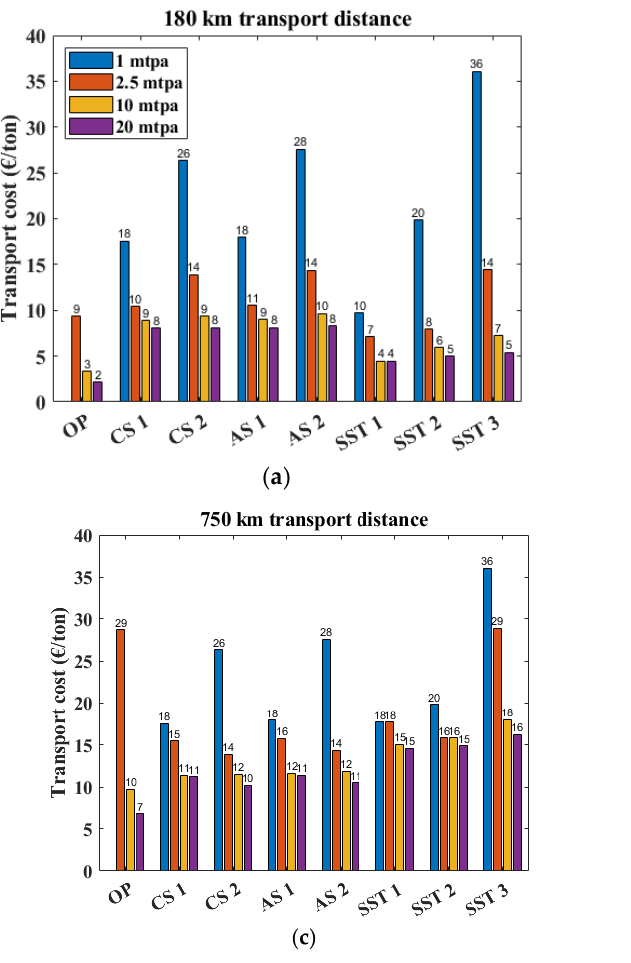
Figure 7. Mean cost per ton of CO 2 results on different source volumes and transport distances: ( a ) 180 km; ( b ) 500 km; ( c ) 750 km; ( d ) 1500 km. OP: Offshore pipeline; CS 1: Crewed ship (Cargo 22,000 m 3 ); CS 2: Crewed ship (Cargo 41,000 m 3 ); AS 1: Autonomous ship (Cargo 22,000 m 3 ); AS 2: Autonomous ship (Cargo 41,000 m 3 ); SST 1: Subsea shuttle tanker (Cargo 10,569 m 3 ); SST 2: Subsea shuttle tanker (Cargo 23,239 m 3 ); SST 3: Subsea shuttle tanker (Cargo 40,730 m 3 ).